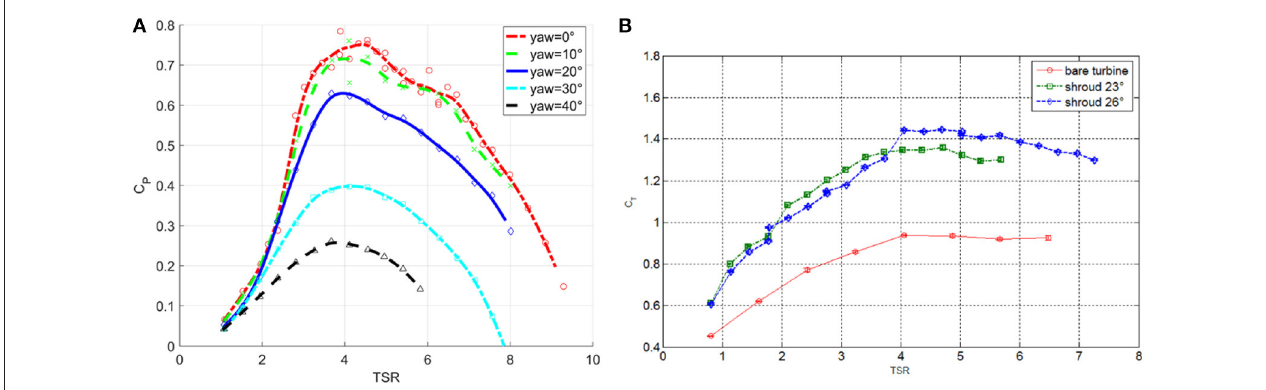
FIGURE 4 | Effect of yaw misalignment on ducted turbine ( φ = 26 ◦ ) on measured power coefficient. Current speed 1.5 m/s (A) . Comparison of measured rotor thrust coefficients for 3 different configurations (bare rotor, ducted rotor with ϕ = 23 ◦ , ducted rotor with ϕ = 26 ◦ ). Current speed 2.0 m/s (B)